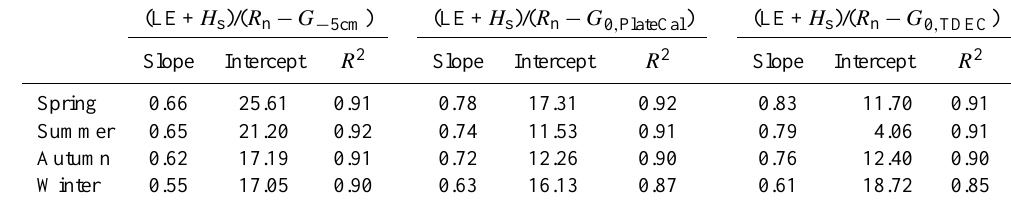
Table 4. Energy balance closure from 5-cm-depth soil heat flux vs surface soil heat flux.